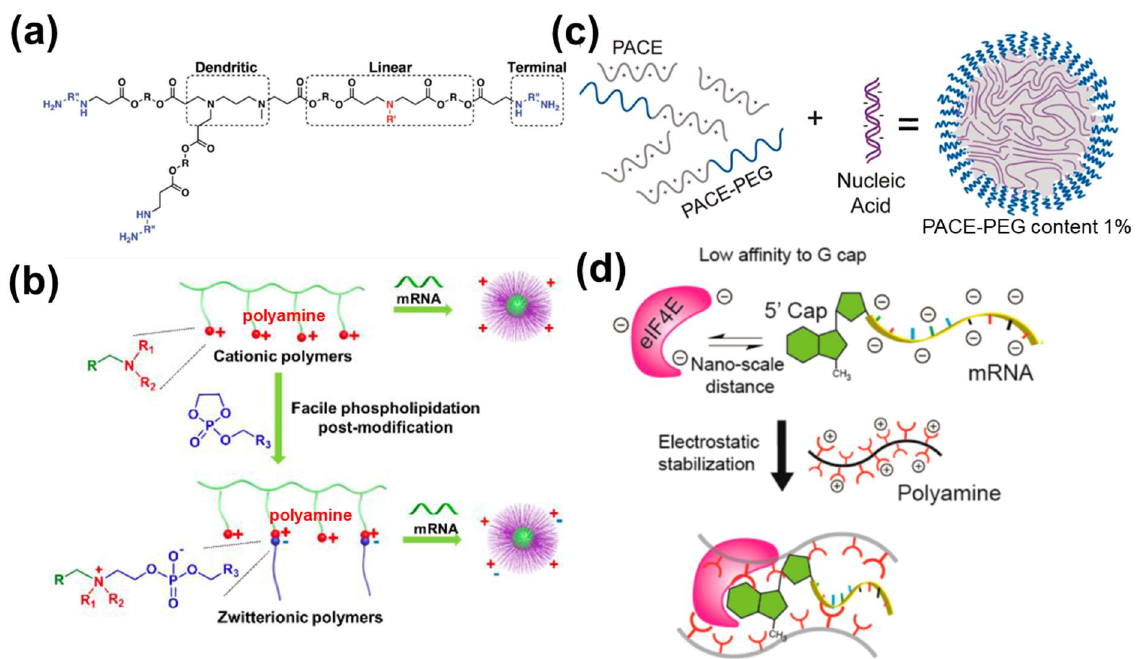
Figure 5. Polymers and mRNA stability. ( a ) The structure of a branched PBAE, reproduced with permission [56]; ( b ) phospholipidation of cationic polymers creates zwitterionic polymers, conferring higher stability against negatively charged proteins, reproduced with permission [57]; ( c ) the loading of nucleic acids on conjugated polymer PACE–PEG and formation of micellar structure. Reproduced with permission [58]; ( d ) preassembly of mRNA translation initiation complex prohibits decapping, reproduced with permission [23].